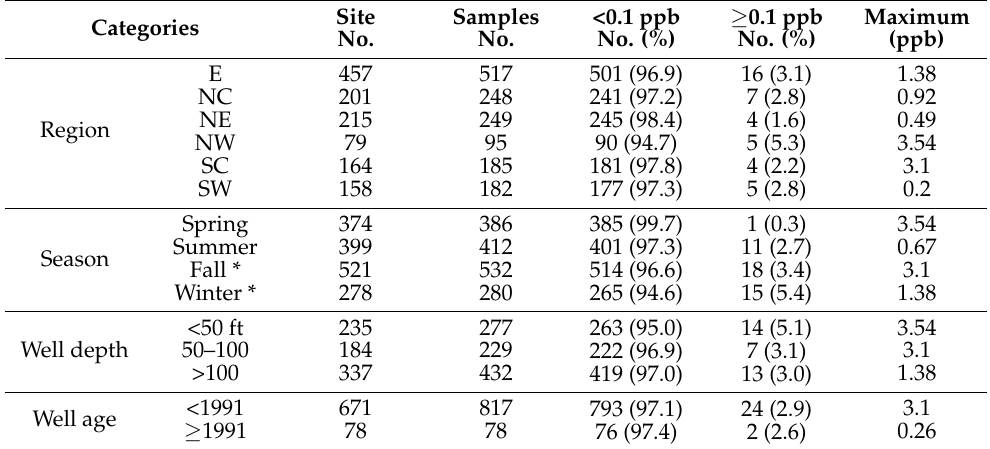
Table 10. Occurrence of DIA in Private Wells.